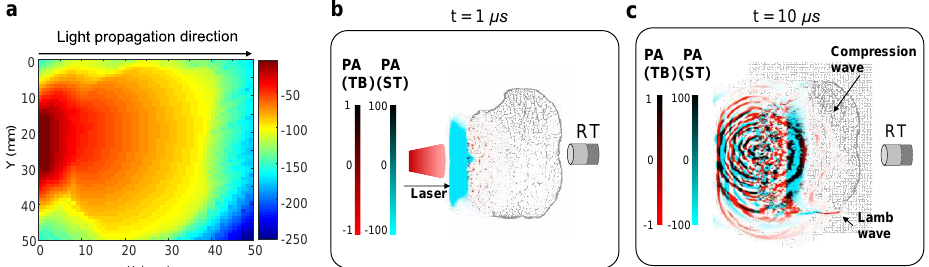
Figure 4. Photoacoustic simulation results. ( a ) Simulation results of light distribution in bone. ( b ) Simulation results at t = 1 µs in the PA mode. The red and cyan colors indicate the signals from TB and ST, respectively, which represent the initial pressures. ( c ) Simulation results at t = 10 µs in the PA mode. The compression wave and Lamb wave are marked by the arrows. TB, trabecular bone; ST, soft tissue; RT, receiving transducer.